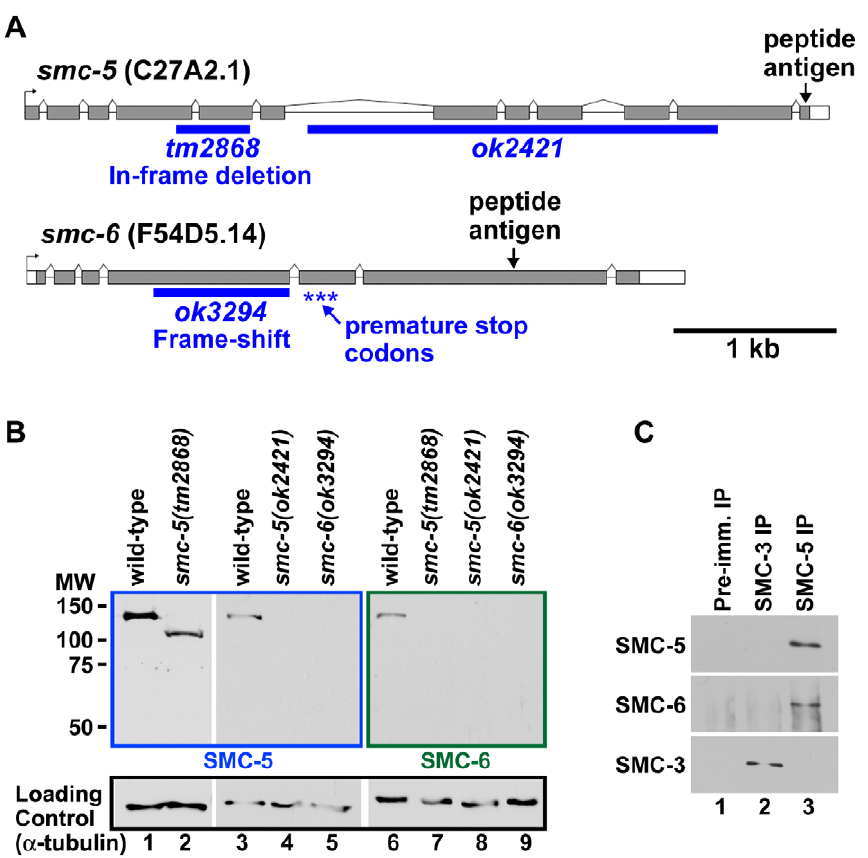
Figure 1. Identification and detection of the SMC-5 and SMC-6 homologs in C.elegans . (A) Two diagrams illustrate the predicted exon-intron structures of the smc-5 and smc-6 genes and the locations of the tm2868 , ok2421 and ok3294 deletion mutations (blue bars). The exons are represented by the grey boxes and the introns by the black lines. The tm2868 deletion removes 444 basepairs from exon 4 to exon 5, and it is predicted to generate an in-frame deletion of 133 codons. The ok2421 deletion removes 2,420 basepairs from intron 6 to exon 11. The ok3294 lesion deletes the last 830 basepairs from exon 4, and should result in a frame-shift at codon 192 and the introduction of premature termination codons (asterisks). The corresponding peptide regions used for antibody production are indicated. (B) Western blot analysis of whole worm lysates using antibodies raised to SMC-5 (lanes 1–5), antibodies to SMC-6 (lanes 6–9), and antibodies to alpha-tubulin as a loading control (lanes 1–9). The genotypes of the worms used are indicated above the western blot images. Two-fold more lysates were loaded in lanes 1–2 to detect the smaller SMC-5 product from the smc- 5(tm2868) mutant lysates. (C) Western blot analysis of immunoprecipitates from wild-type embryo lysates using pre-immune (lane 1), SMC-3 (lane 2) and SMC-5 antibodies (lane 3). Antibodies for western blot detection are indicated to the left of the western blot